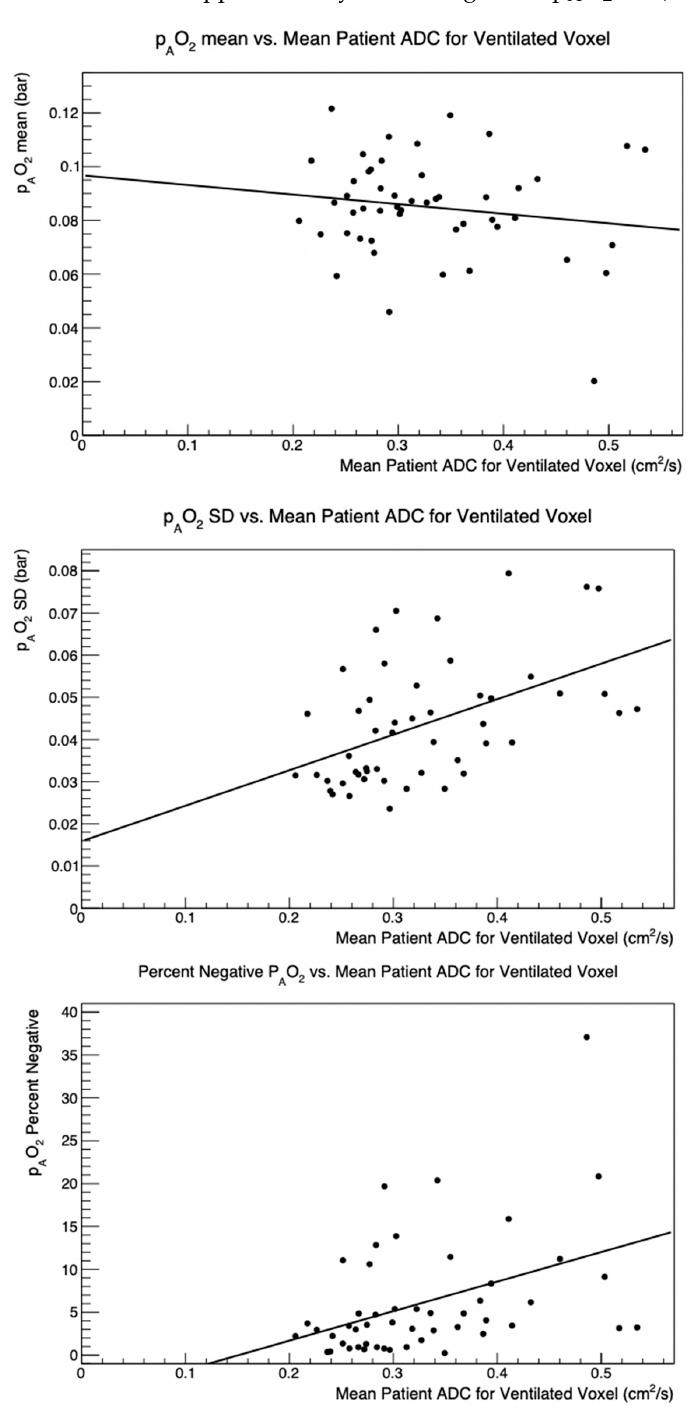
Figure 3. p A O 2 mean vs. ADC mean (top), p A O 2 SD vs. ADC mean (center) Percent negative p A O 2 vs. ADC mean (bottom). Each measurement corresponds to an individual participant imaged with polarized 3 He from the MESA COPD Study.